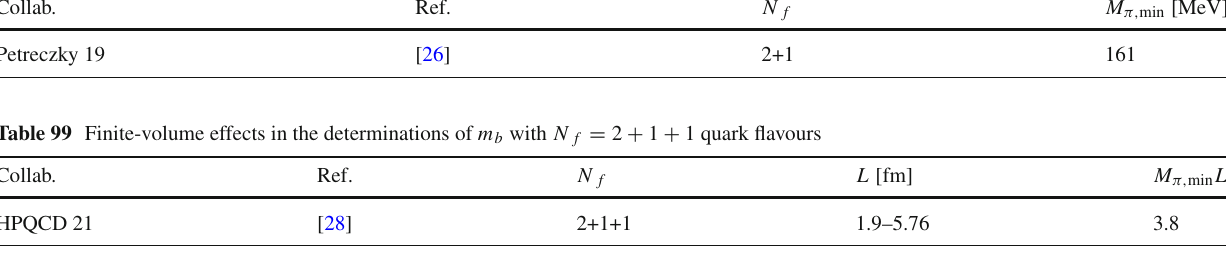
Table 98 Chiral extrapolation/minimum pion mass in the determinations of m b with N f = 2 + 1 quark flavours Collab.